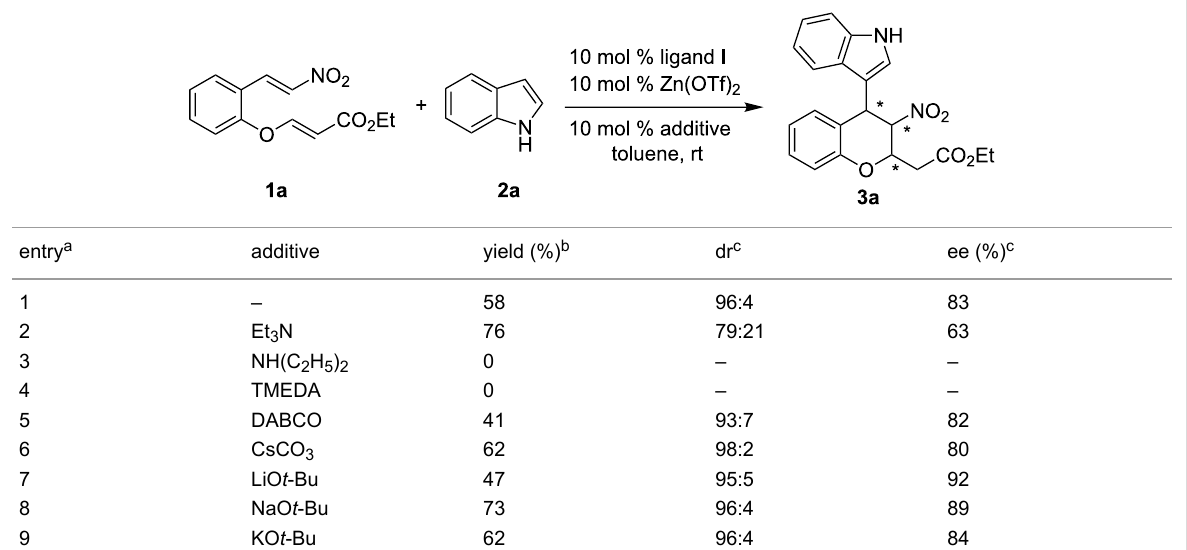
Table 3: Effect of additives on asymmetric tandem Friedel–Crafts alkylation/Michael addition